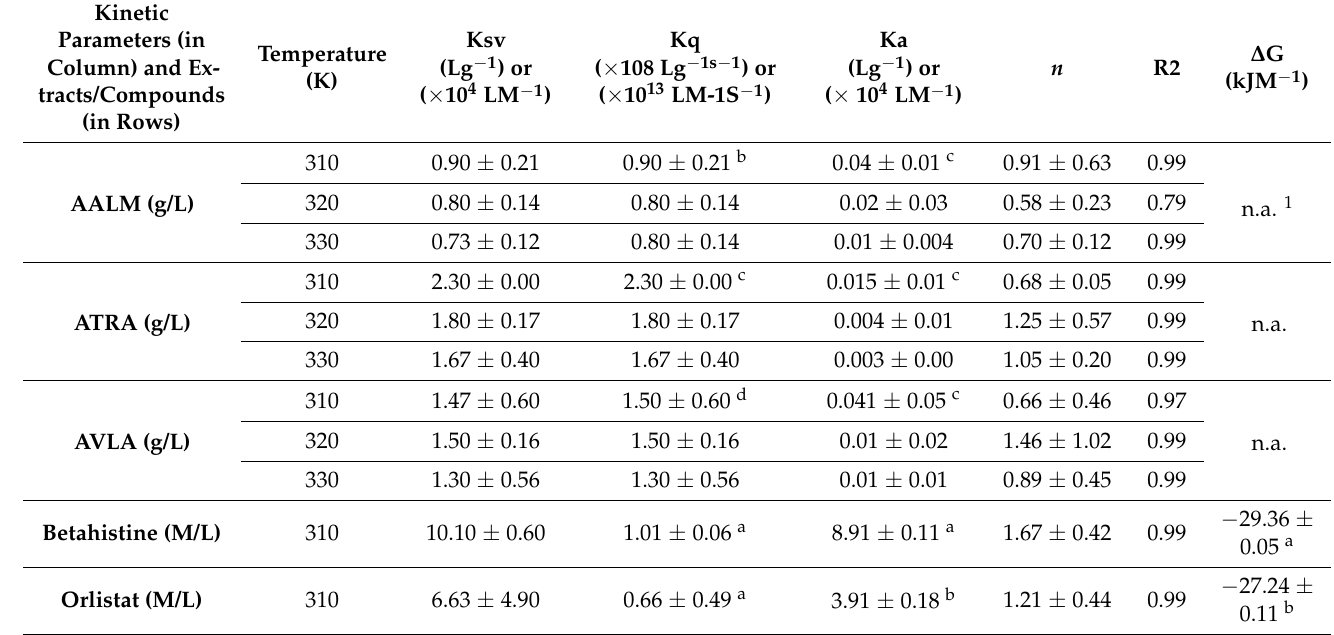
Figure 5. Kinetics of PPL fluorescence quenching: Stern-Volmer plots show F 0 /F vs. concentrations [Q]. Table 5. Summary of fluorescence quenching using Stern-Volmer’s kinetic